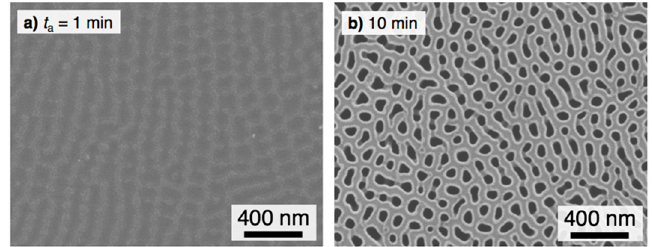
Figure 7. SEM images of the aluminum specimen anodized at 283 K and 80 V ( a ) t a = 1 min and ( b ) 10 min.